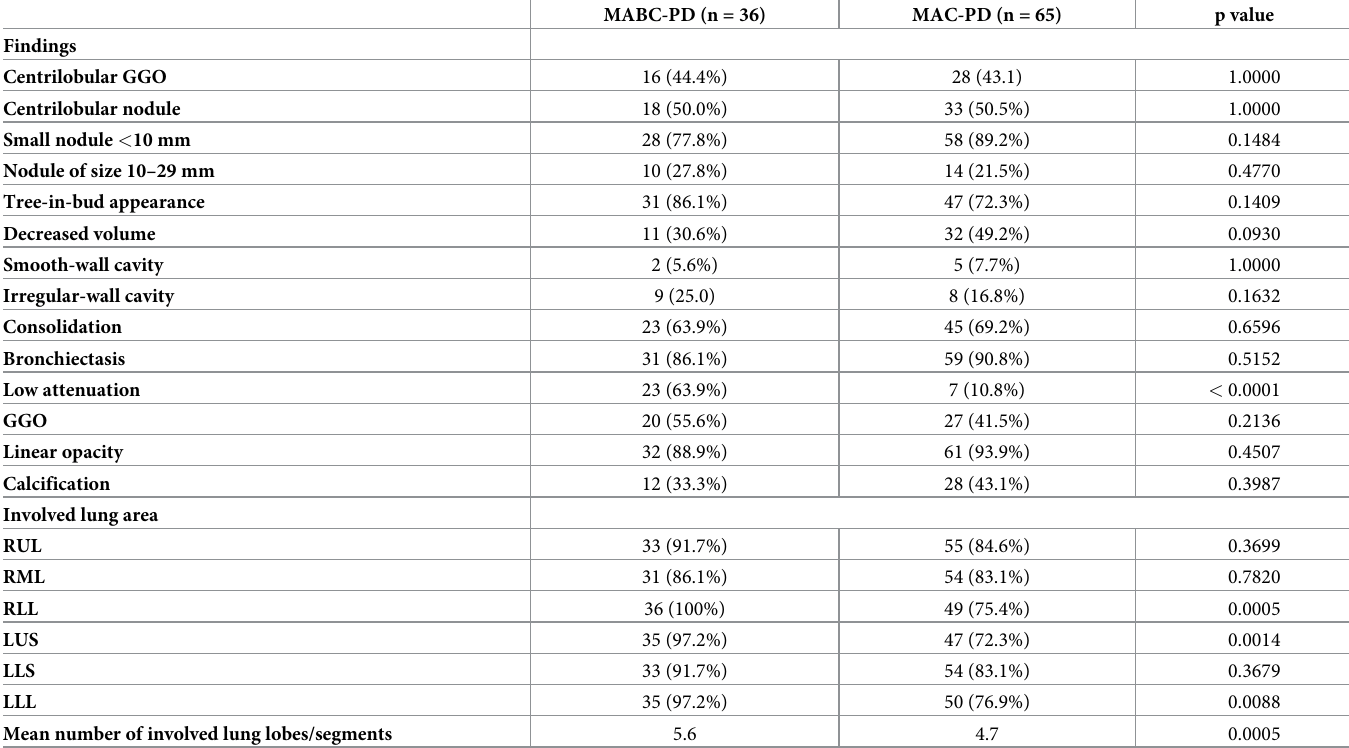
Table 3. Detailed comparison of the imaging findings between the MABC-PD and MAC-PD